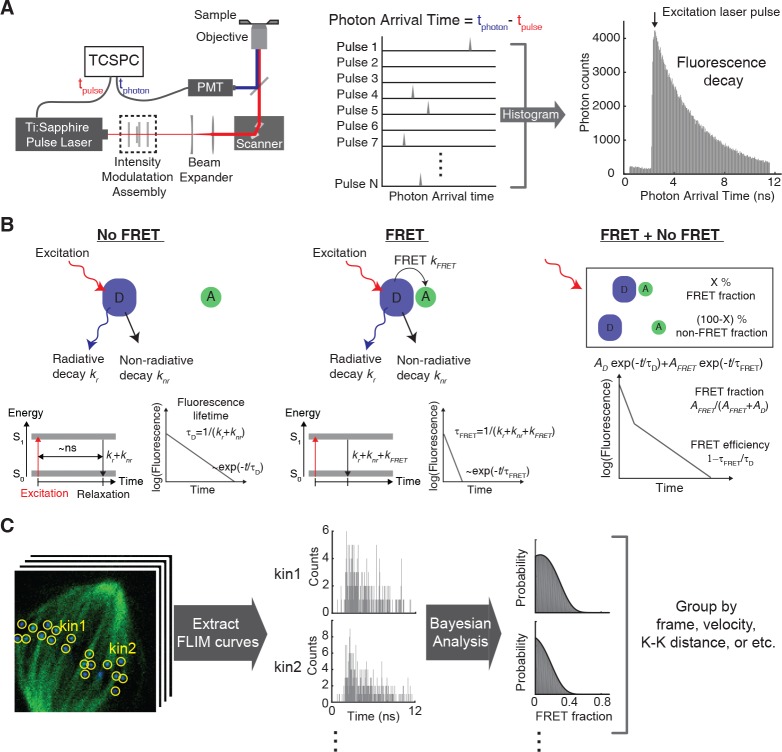
Kinetochore FLIM-FRET measurement.(A) Illustration of fluorescence decay acquisition in a TCSPC (time-correlated single photon counting) FLIM system. A Ti:Sapphire pulsed laser is used for excitation and a photomultiplier tube (PMT) for detection. The photon arrival time, the difference in timing between the emitted photon and excitation laser pulse, is measured by TCSPC, which is accumulated to a fluorescence decay curve over many laser repetition periods. (B) The fluorescence lifetime is the average time the fluorophore stays in the excited state. (left) When the donor fluorophore (D) is not engaged in FRET with an acceptor (A) fluorophore, the donor fluorophore has a single-exponential fluorescence decay with fluorescence lifetime τD=1/(kr + knr), where kr and knr are the radiative and non-radiative decay rates, respectively. (middle) FRET provides an additional relaxation pathway to the excited donor, reducing the fluorescence lifetime of the donor to τFRET = 1/(kr + knr + kFRET), where kFRET is the FRET rate. (right) The fluorescence decay of a mixture of donors engaged in FRET and not engaged in FRET is a sum of two exponentials with two different lifetimes, τD and τFRET, which corresponds to the non-FRET and FRET populations, respectively. The relative amplitude of the short-lifetime exponential decay provides the fraction of the FRET population, and the lifetime ratio provides the intrinsic FRET efficiency. (C) TCSPC FLIM provides fluorescence decay curve at each pixel, and the total photon counts in each pixel provides a two-photon fluorescence intensity image. To quantify the FRET fraction at each kinetochore, kinetochores were identified based on the intensity image, then the fluorescence decay curves in the pixels within each kinetochore were summed. Then we performed a Bayesian analysis to obtain the posterior distribution of the FRET fraction at each kinetochore. The posterior distributions of the kinetochores in a group of kinetochores were combined by multiplication to compute the mean and SEM of the FRET fraction for the group.